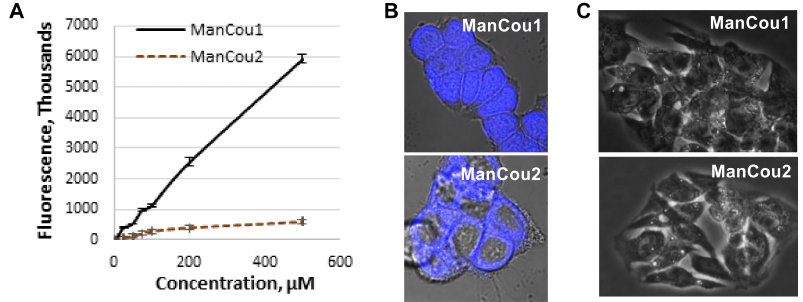
Figure 3. ManCou uptake analysis. ( A ) Concentration-dependent uptake in MCF7 cells in 96-well plate; ( B ) brightfield and fluorescence (DAPI) overlay of confocal Z-stack images of MCF7 with ManCou1 and ManCou2; ( C ) brightfield and fluorescence (DAPI) overlay of confocal Z-stack images of HepG2 cells with ManCou1 and ManCou2. Images taken with 20 µ M ManCous at 405 nm excitation and 461 nm emission (60 × for MCF7 cells and 40 × for HepG2